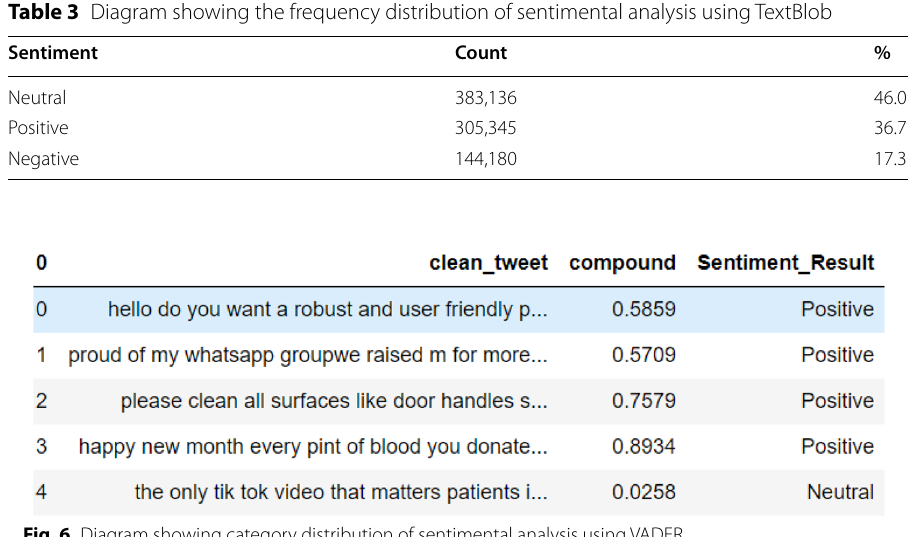
Fig. 6 Diagram showing category distribution of sentimental analysis using VADER